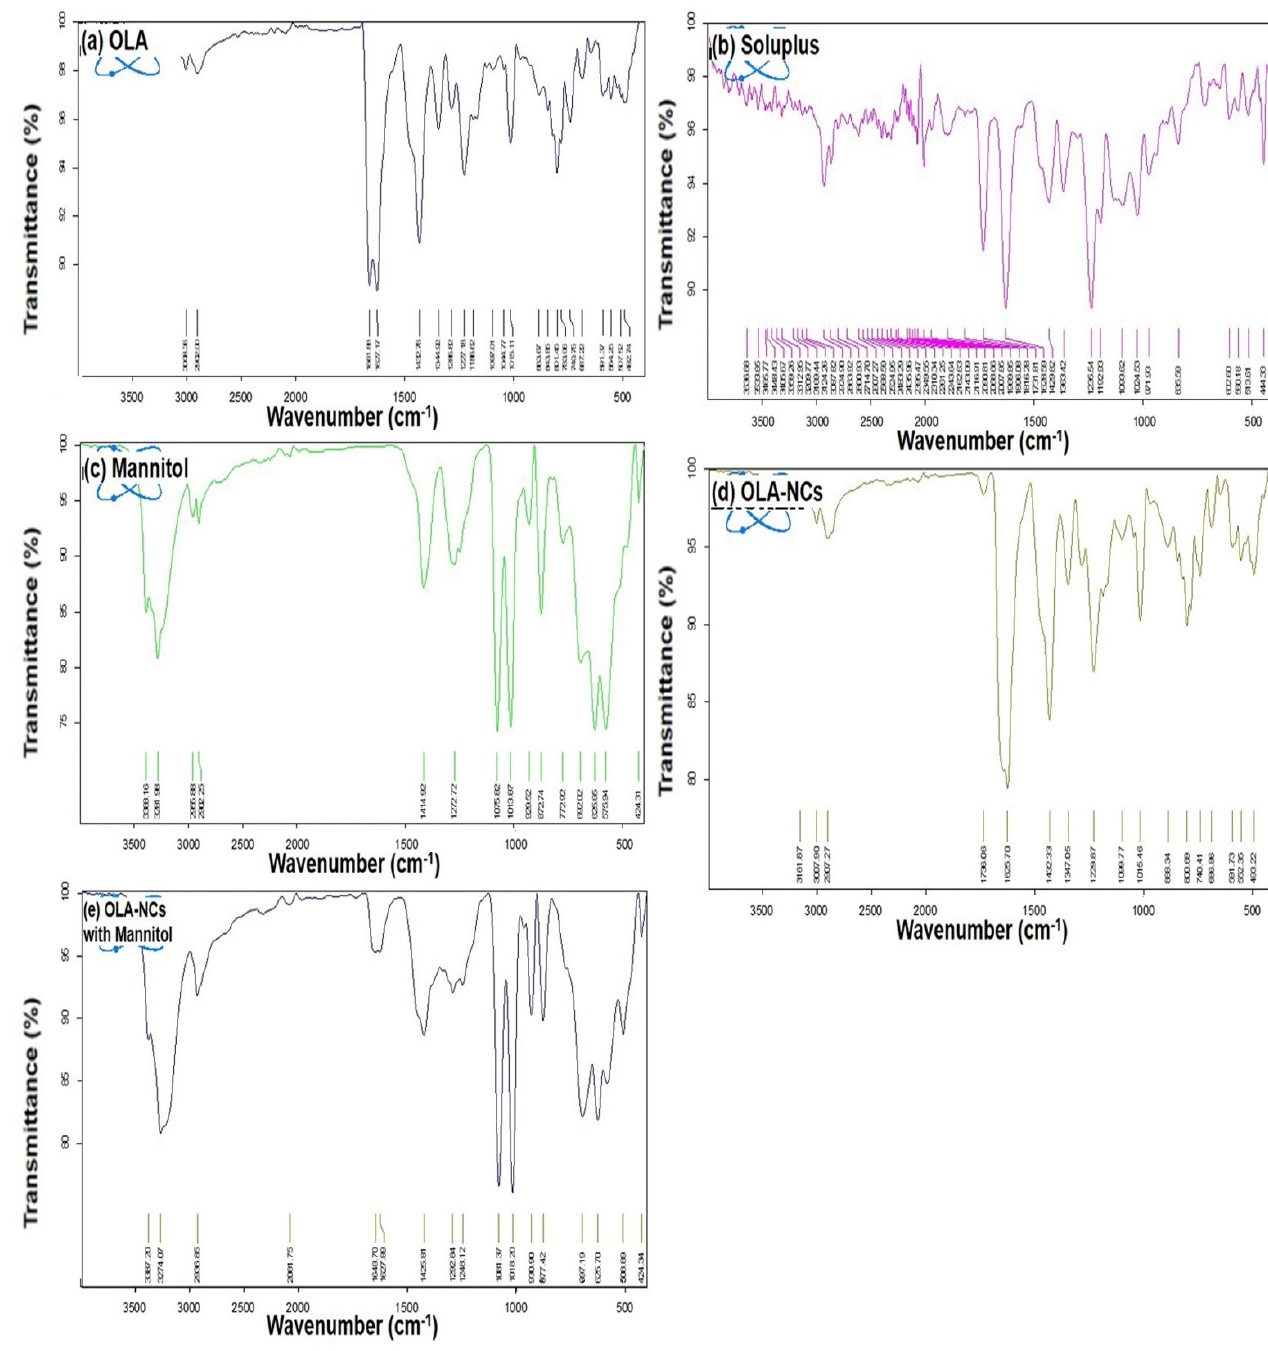
Figure 4. FTIR-spectra of pure OLA ( a ); Soluplus ® ( b ); mannitol ( c ); lyophilized OLA-NCs-2 ( d ) and lyophilized OLA-NCs-2 with mannitol ( e ).